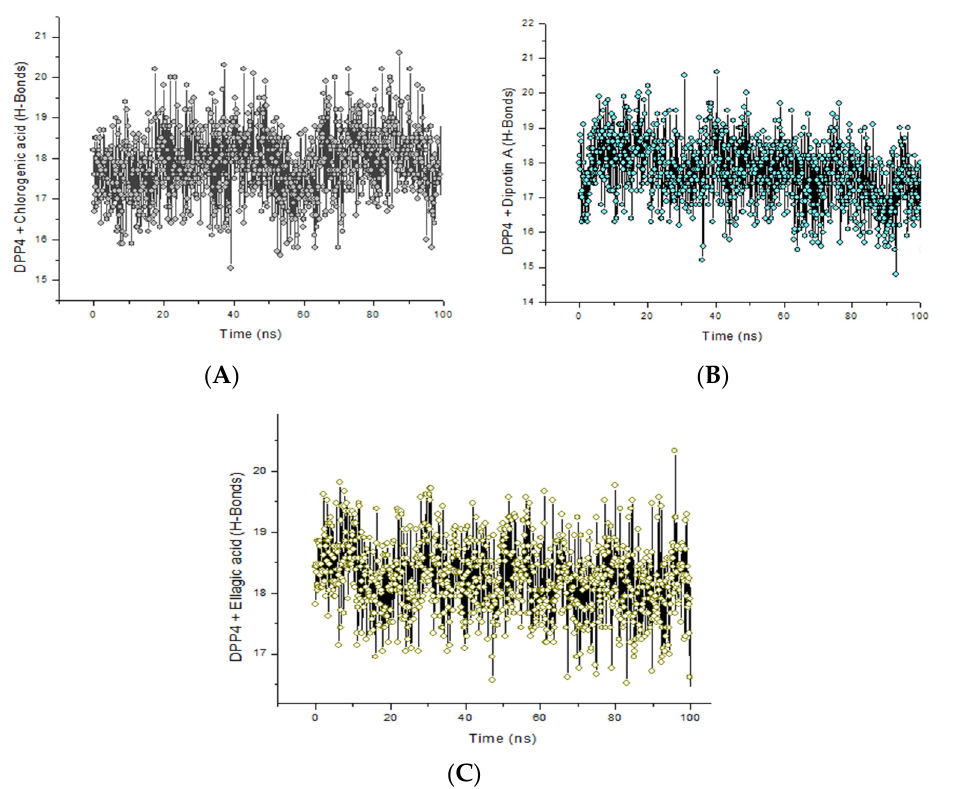
Figure 4. Backbone hydrogen bonds along the 100 ns simulation trajectory for DPP-IV in complex with ( A ) chlorogenic acid, ( B ) Diprotin A and ( C ) ellagic acid